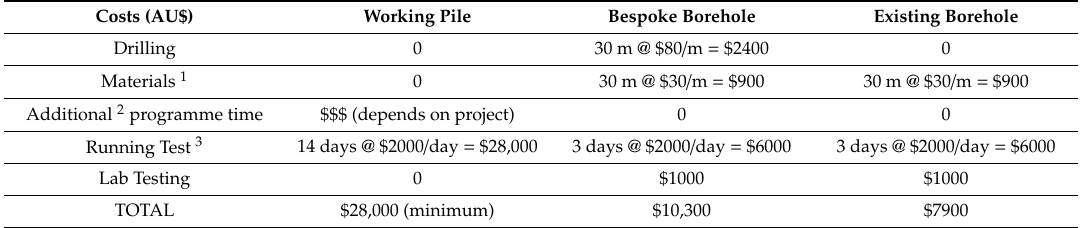
Table 7. Additional cost of three di ff erent site investigation methods for energy pile